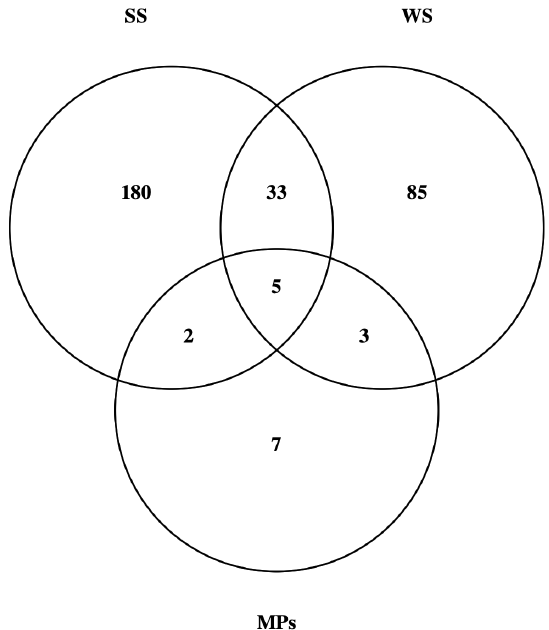
Figure 2. Venn diagram showing the number of exclusive and shared taxa among matrices: solid sediment (SS), watery sediment (WS), and microplastics (MPs).